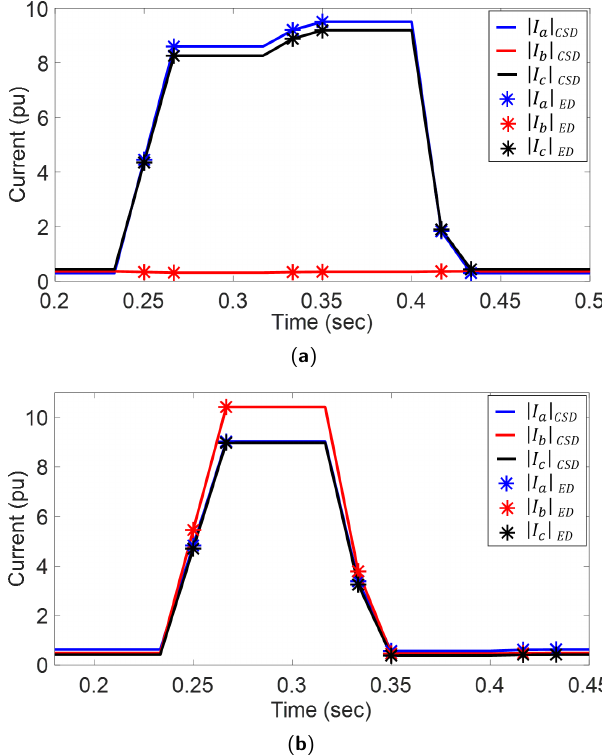
Figure 7. Measurements transmitted by the edge device with and without context aware policy (CAP) for sensor 2 ( a ), measurements transmitted by the edge device with and without CAP for sensor 4 ( b ).